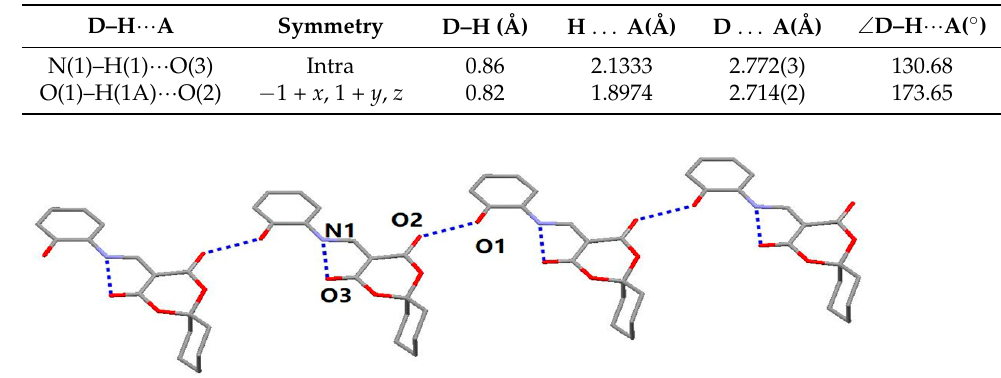
Figure 2. The 1D-chained structure for HMD.